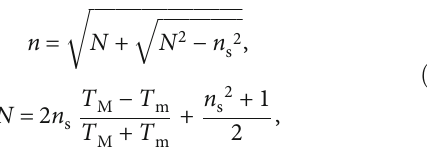
Figure 6: Variation of the thickness of Al-Ni-codoped SnO fi lms as a function aluminum-doping